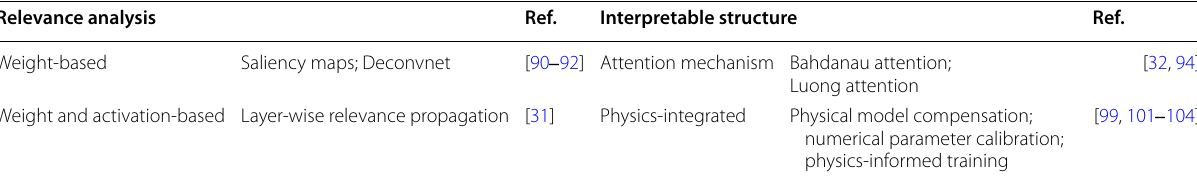
Table 4 Representative techniques for DL model interpretation Relevance analysis